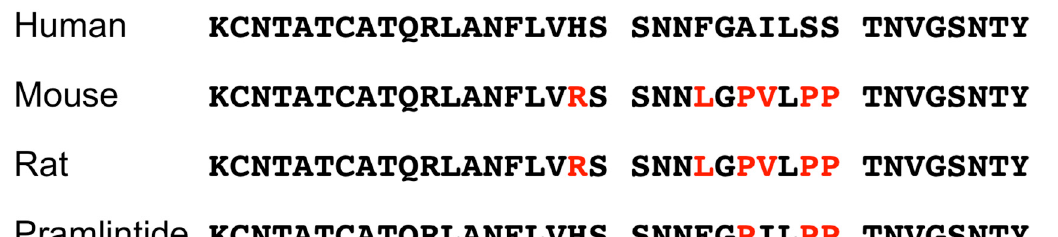
Figure 3. Sequence alignment of the amino acid sequences of human, mouse, and rat amylins and pramlintide. Amino acids that differ from human amylin are highlighted in red.